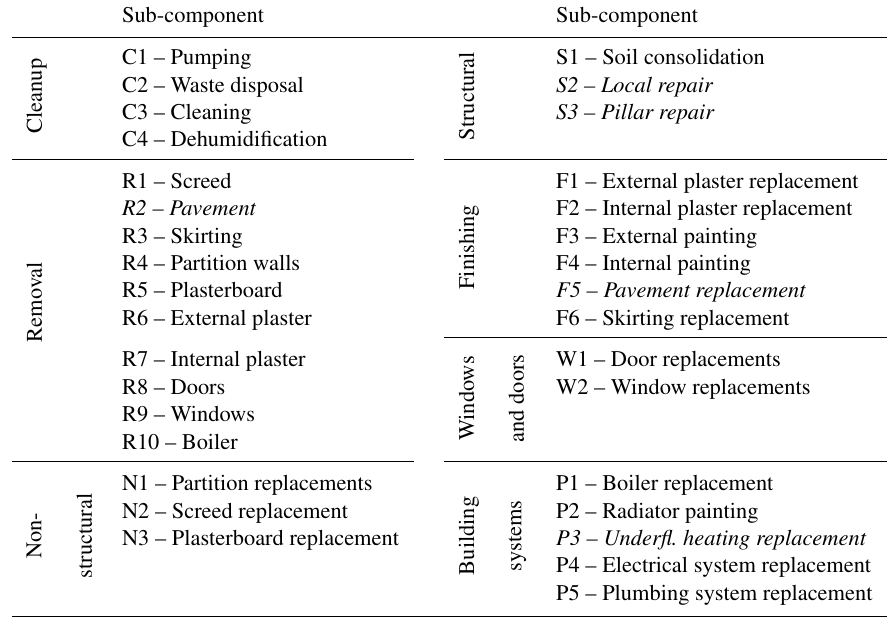
Table 5. Damage components considered in INSYDE. Italic: not taken into account in this study. Sub-component